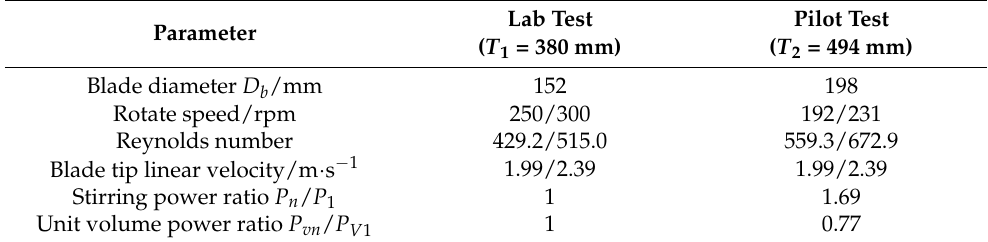
Table 3. Working condition parameters based on the same blade tip linear velocity.